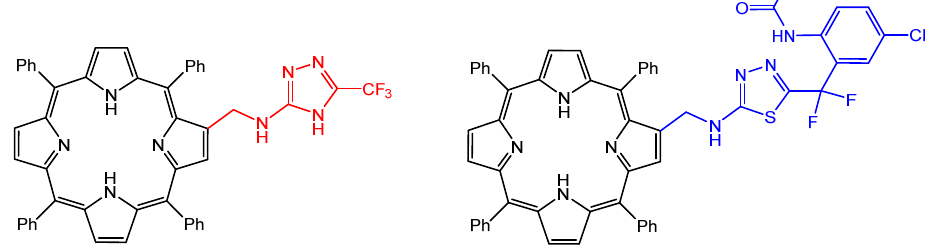
Figure 4. Structures of the amino-triazole and amino-thiadiazole free-base porphyrins with enhanced antiparasitic activity, prepared by Bastos et al. [108].